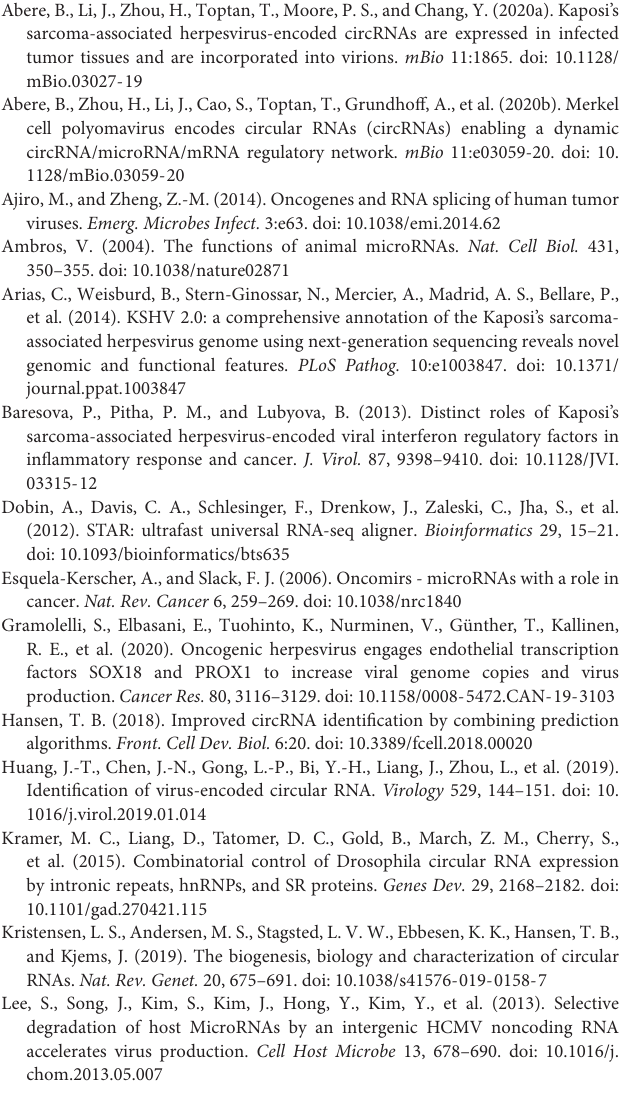
Supplementary Table 1 | Primers. List of primers utilized for RT-qPCR, ddPCR, and amplicon sequencing. Supplementary Table 2 | Alignment statistics. Statistics of detected back-splice junction- containing reads from RNA-Seq projects used here. Supplementary Table 3 | Detected circRNAs from RNA-Seq. Detected BSJ-containing reads by CIRCexplorer2 for RNA-Seq and circRNA-Seq. All detected BSJ reads from PEL5-LN, BCBL1 (GSM3543751), BC1 (GSM3309426), and triplicates of infected LEC (rK_LEC_siCon, PRJEB31253) as well as BSJ reads at EBV BHLF1 gene from Akata (GSM3258256 and GSM3258253), Jijoye (GSM3258264), JY (GSM3258265), Mutu I (GSM3258260 and GSM3258259), SNU719 (GSM3258268) cell lines are included. Supplementary Table 4 | BSJ detected from amplicons. Detected BSJ-containing reads by CIRCexplorer2 for amplicon-Seq.